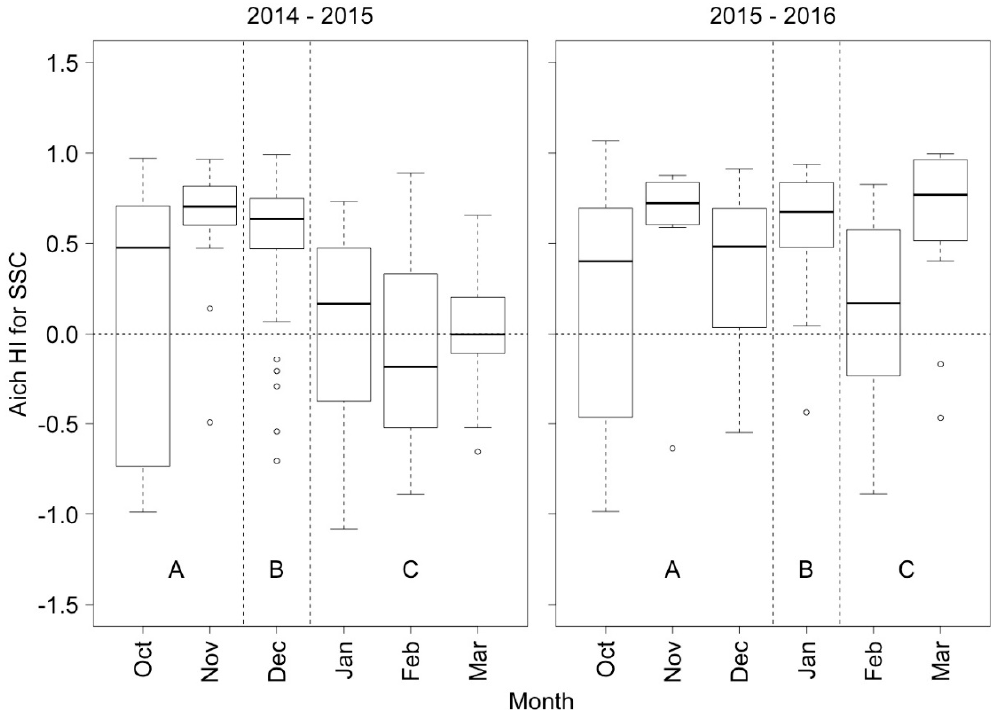
Figure 8. The hysteresis index (calculated following Aich et al. [28]) between water discharge and suspended sediment concentration grouped by month in the two ablation seasons in the Estero Morales. The main origin of runoff is split in snowmelt ( A ), snow and glacier melting ( B ) and glacier melting ( C ).